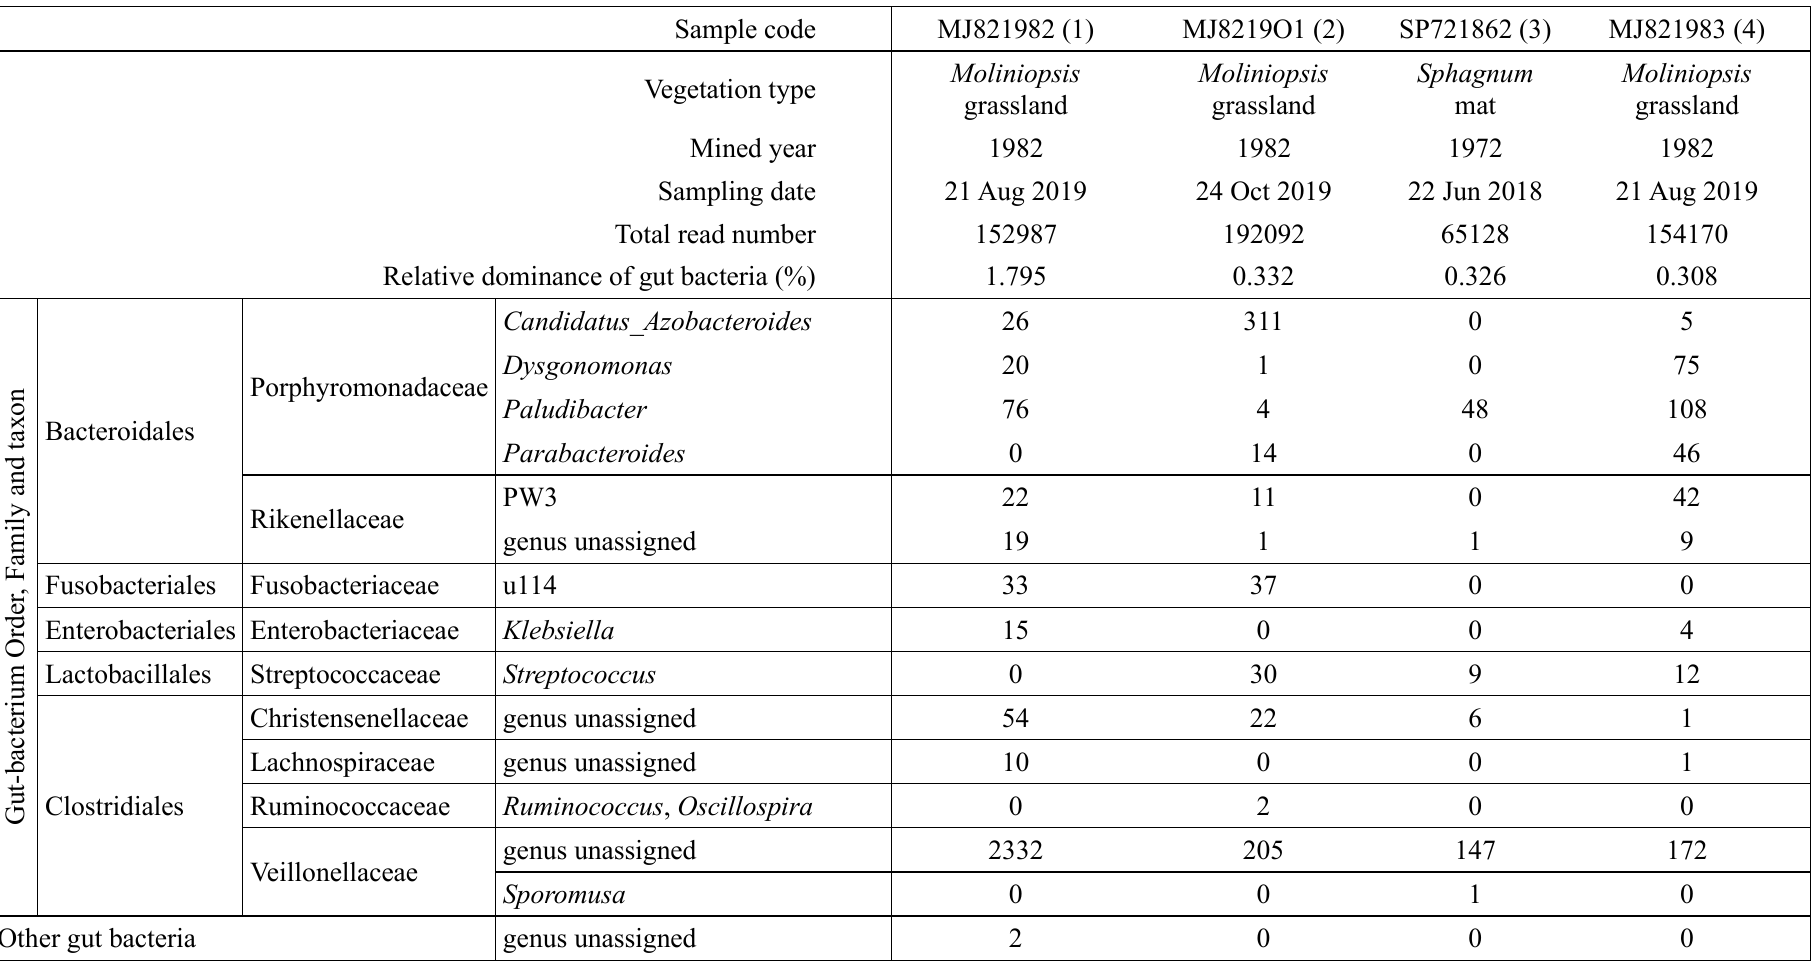
Table 2. Numbers of reads on the OTUs of gut bacteria in the four samples that show relatively high occurrence of gut bacteria, coded as 1 to 4. All of these samples are peat. The sample codes correspond to the bold outlier labels in Figure